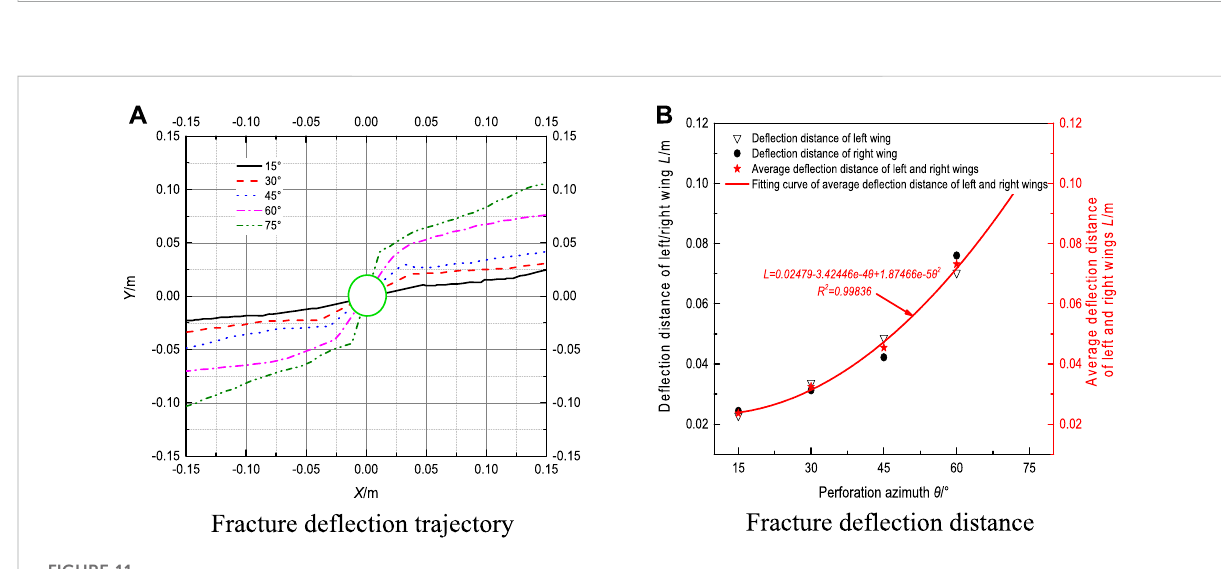
Frontiers in Earth